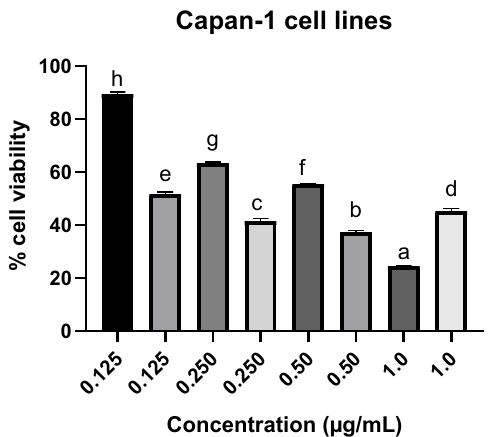
Figure 7: Cytotoxic e ff ect of extract and AgNPs@Org on L929 cell lines. The fi rst and second columns indicate the extract and nano - particles, respectively. Di ff erent letters indicated signi fi cantly dif - ferent ( p < 0.05 ) compared in each assay.